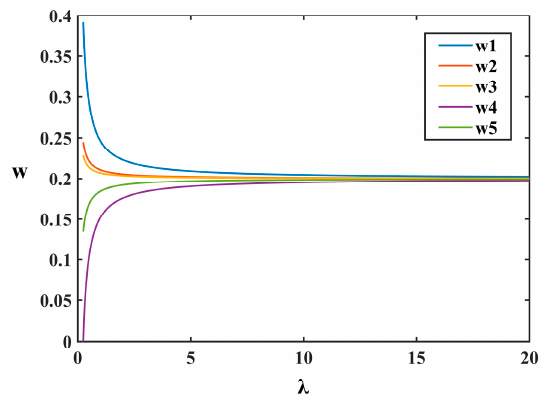
Figure 9. The priority weight of each criterion with a change of λ .